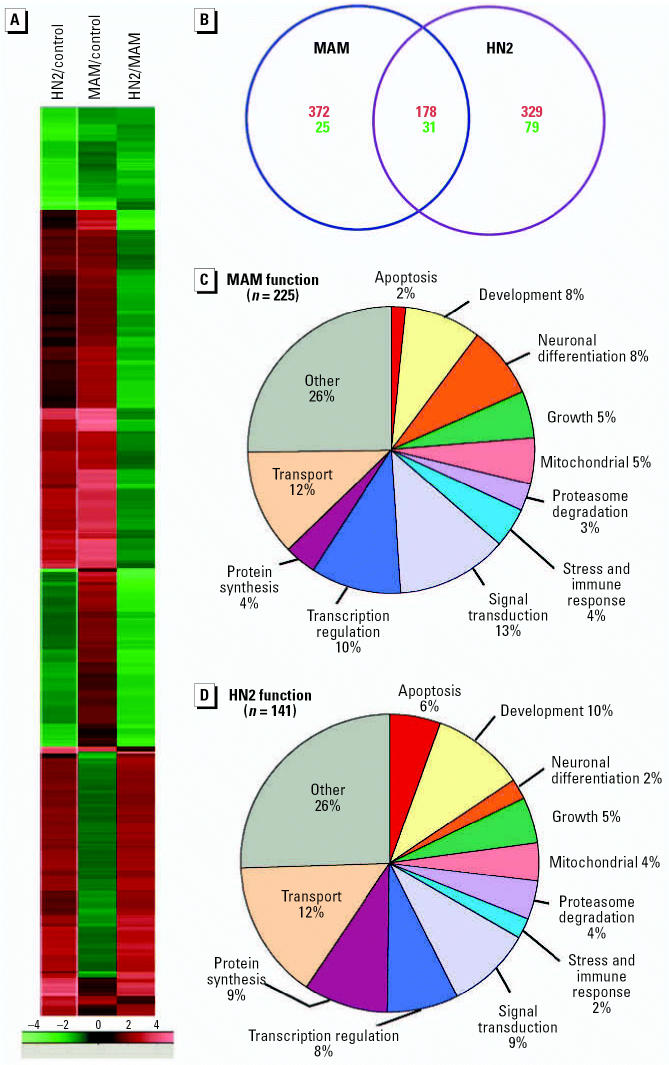
Effect of MAM and HN2 on global gene expression in cultured cerebellar neurons. Mouse cerebellar granule cell cultures were treated with MAM (100 μM) or HN2 (1.0 μM) for 24 hr. (A) Gene expression changes were induced by MAM or HN2. All genes with log2 MAM/control or HN2/control gene expression ratios > 1 or < –1 were normalized by the absolute valued of the maximum fold change for the gene and grouped by hierarchical clustering using Euclidean distances. (n = 606 genes for MAM and 617 genes for HN2). (B) Venn diagram depicting the overlap between MAM- and HN2-responsive genes. Up-regulated (red): numbers represent all genes with significant differences between MAM or HN2 and control-treated neurons and log2 (MAM or HN2/control) > 1. Down-regulated (green): significant differences between MAM or HN2 and control-treated neurons and log2 (MAM or HN2/control) < –1. (C) Functional classes of the genes influenced by MAM. (D) Functional classes of the genes influenced by HN2. Named genes with functional annotations in the Unigene database (http://www.ncbi.nlm.nih.gov/UniGene) were categorized by broad functional class.